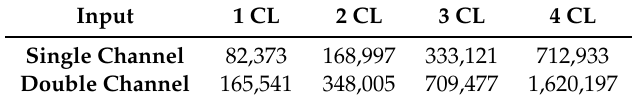
Figure 5. Proposed networks composed of one to four (from left to right) CLs for various representations of the optical flow as input. Table 2. Number of learnable parameters according to the dimensionality of the input of the